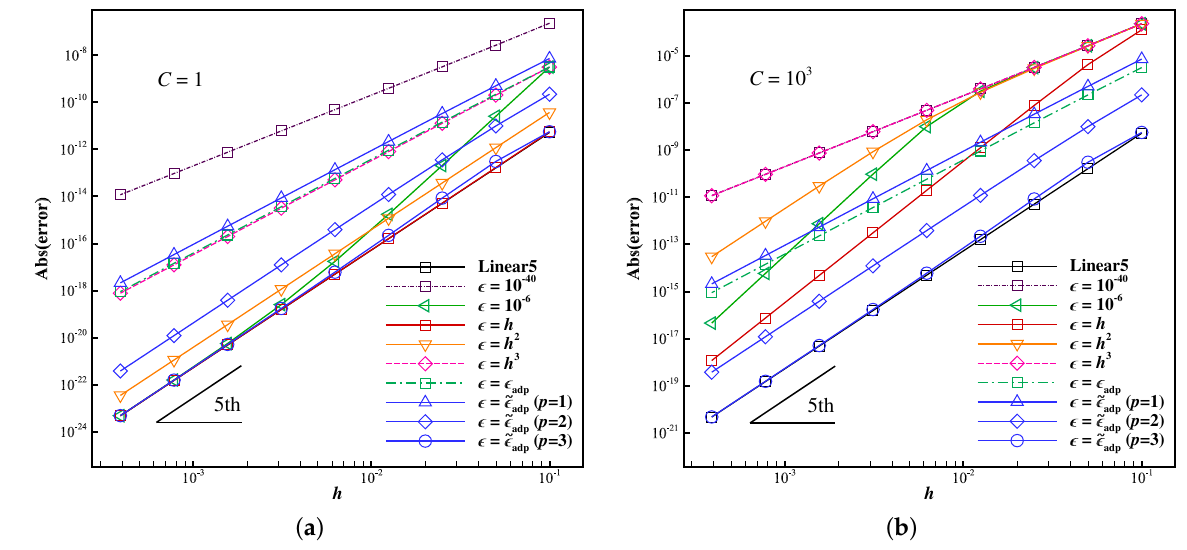
( 0 ) calculated by WCNS5-JS schemes with different (cid:101) : ( a ) C = 1; ( b ) C = 10 3 . Figure 2. The error of g (cid:48) 2 The results in Figure 2 indicate that when C = 1, the small (cid:101) = 10 − 40 yields only third-order accuracy ( β k (cid:29) (cid:101) ), while the larger (cid:101) = 10 − 6 recommended in Ref. [3] first shows super convergence, then gradually reaches the fifth-order accuracy ( β k (cid:28) (cid:101) ) as grid refines. This suggests that the performance of the WCNS5-JS scheme is very sensitive to the relative magnitudes of (cid:101) and β k . More specifically, the larger value ( (cid:101) = 10 − 6 ) will dominate over the smoothness indicators in the refined grid, which in fact hides the deficiency of the classical JS weight function at critical points [4,5]. Setting (cid:101) = Ω ( h 2 ) , the WCNS5-JS scheme can achieve fifth-order accuracy, whereas setting (cid:101) = h 3 or (cid:101) = (cid:101) adp , it only has fourth-order accuracy, which is consistent with the conclusions drawn in Refs.